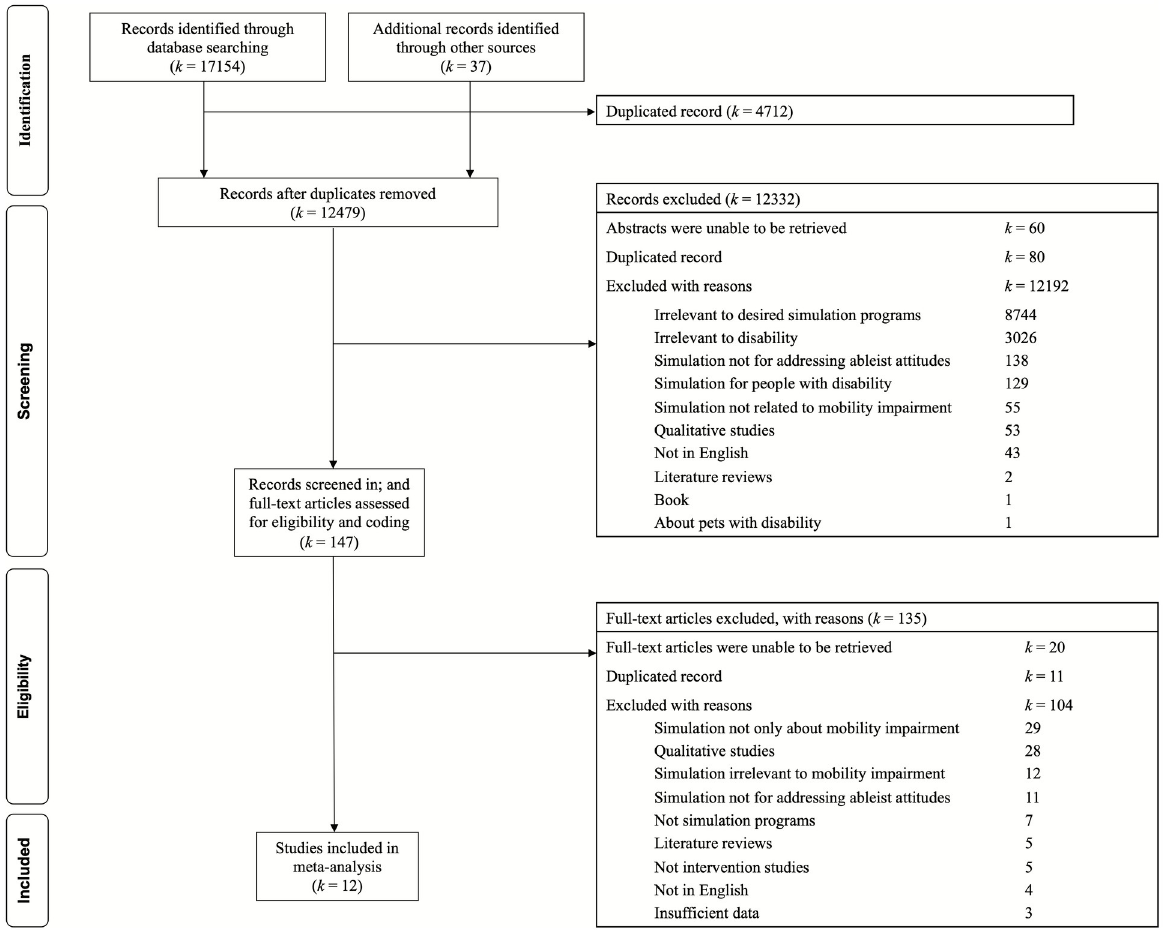
Fig 1. PRISMA study selection flow